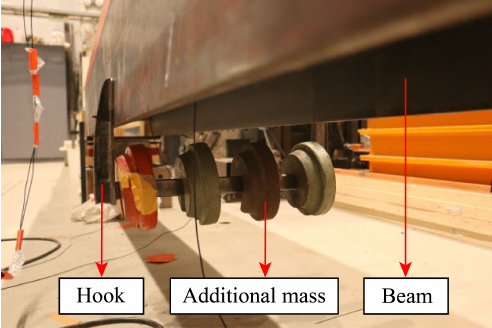
Figure 10. Adding a 20 kg mass to the SSB model.